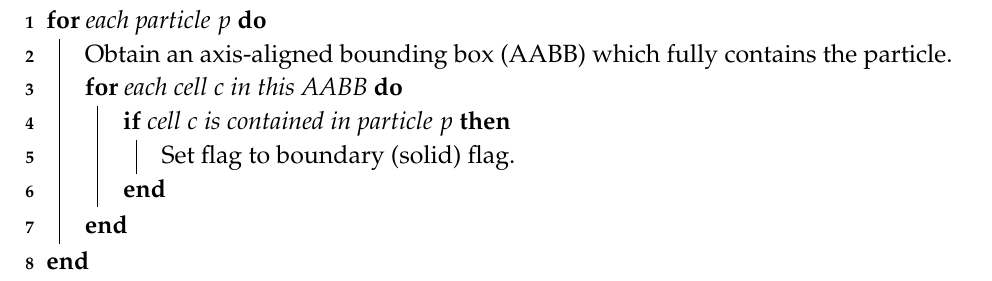
Algorithm 5: Pseudocode for particle-mapping